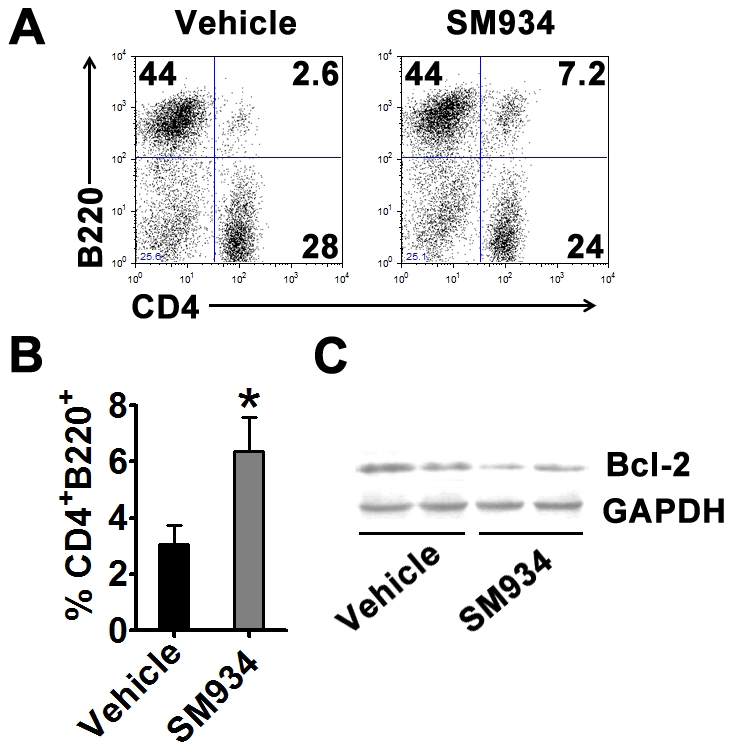
SM934 treatment induced the apoptosis of CD4+ T cells.At the termination of 3 months treatment, female NZB/W F1 mice in vehicle and SM934 (10 mg/kg) treated groups were randomly and averagely divided into 3 sub-groups. Spleens of each sub-group were pooled together. (A) Representative staining of surface CD4 and B220 in splenocytes. (B) Statistical results of percentage of CD4+B220+ population in splenocytes. (C) CD4+ T cells were purified through magnetic negative selection and examined for Bcl-2 expression through western blot analysis. One blot was the mix of two equal splenic samples from treated groups. Shown are mean ± SD, n = 3 in each treated group. * = P<0.05 versus vehicle.